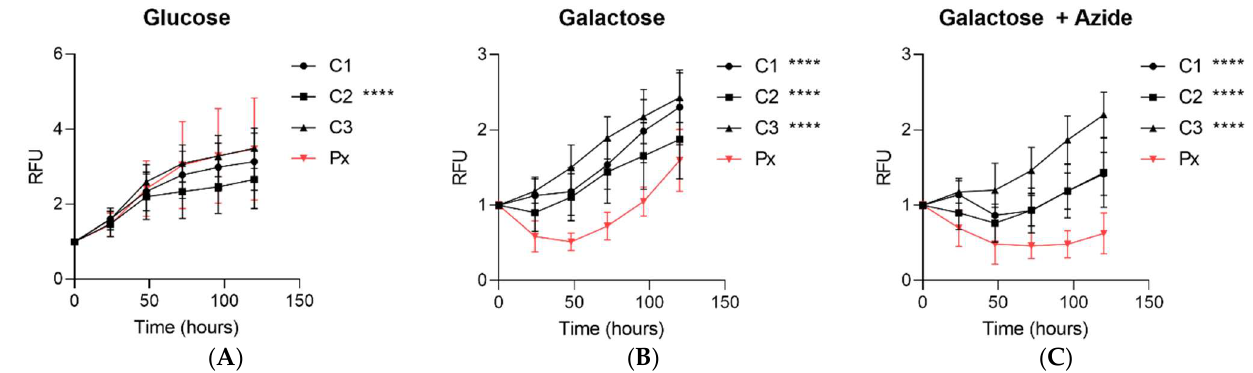
Figure 5. Galactose stress in patient fibroblasts . The growth rate in medium devoid of glucose but containing 5 mM galactose and 50 µM sodium azide was normalized to the cell density at T = 0, to account for the minor variation in the seeding density at T = 0. The normalized growth rate of the patient fibroblasts in ( A ) glucose media, ( B ) galactose media, and ( C ) galactose + azide media was significantly lower than the controls. Two-way ANOVA with Dunnett’s multiple comparisons test; pooled data from n = 3 independent experiments with 6 measurements/ cell line, **** p ≤ 0.0001.